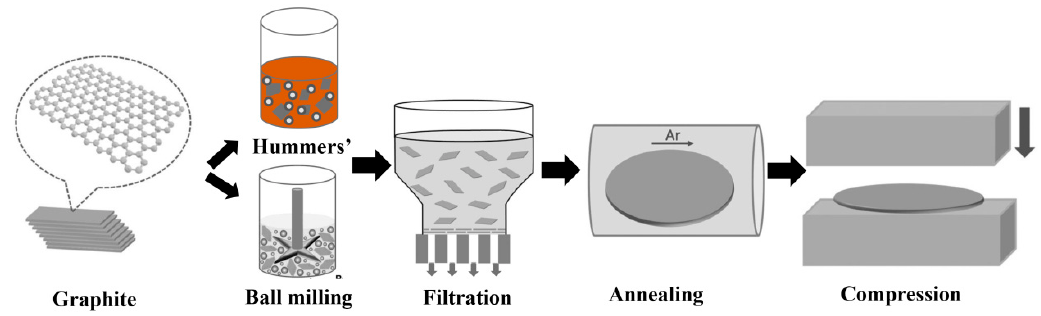
Figure 1. Schematic plot of the process of vacuum filtration for graphene films. Graphite can be oxidized to GO using Hummers’ method, or exfoliated in ball milling. Reproduced and modified from [34] with permission; Copyright 2017 Wiley Online Library.